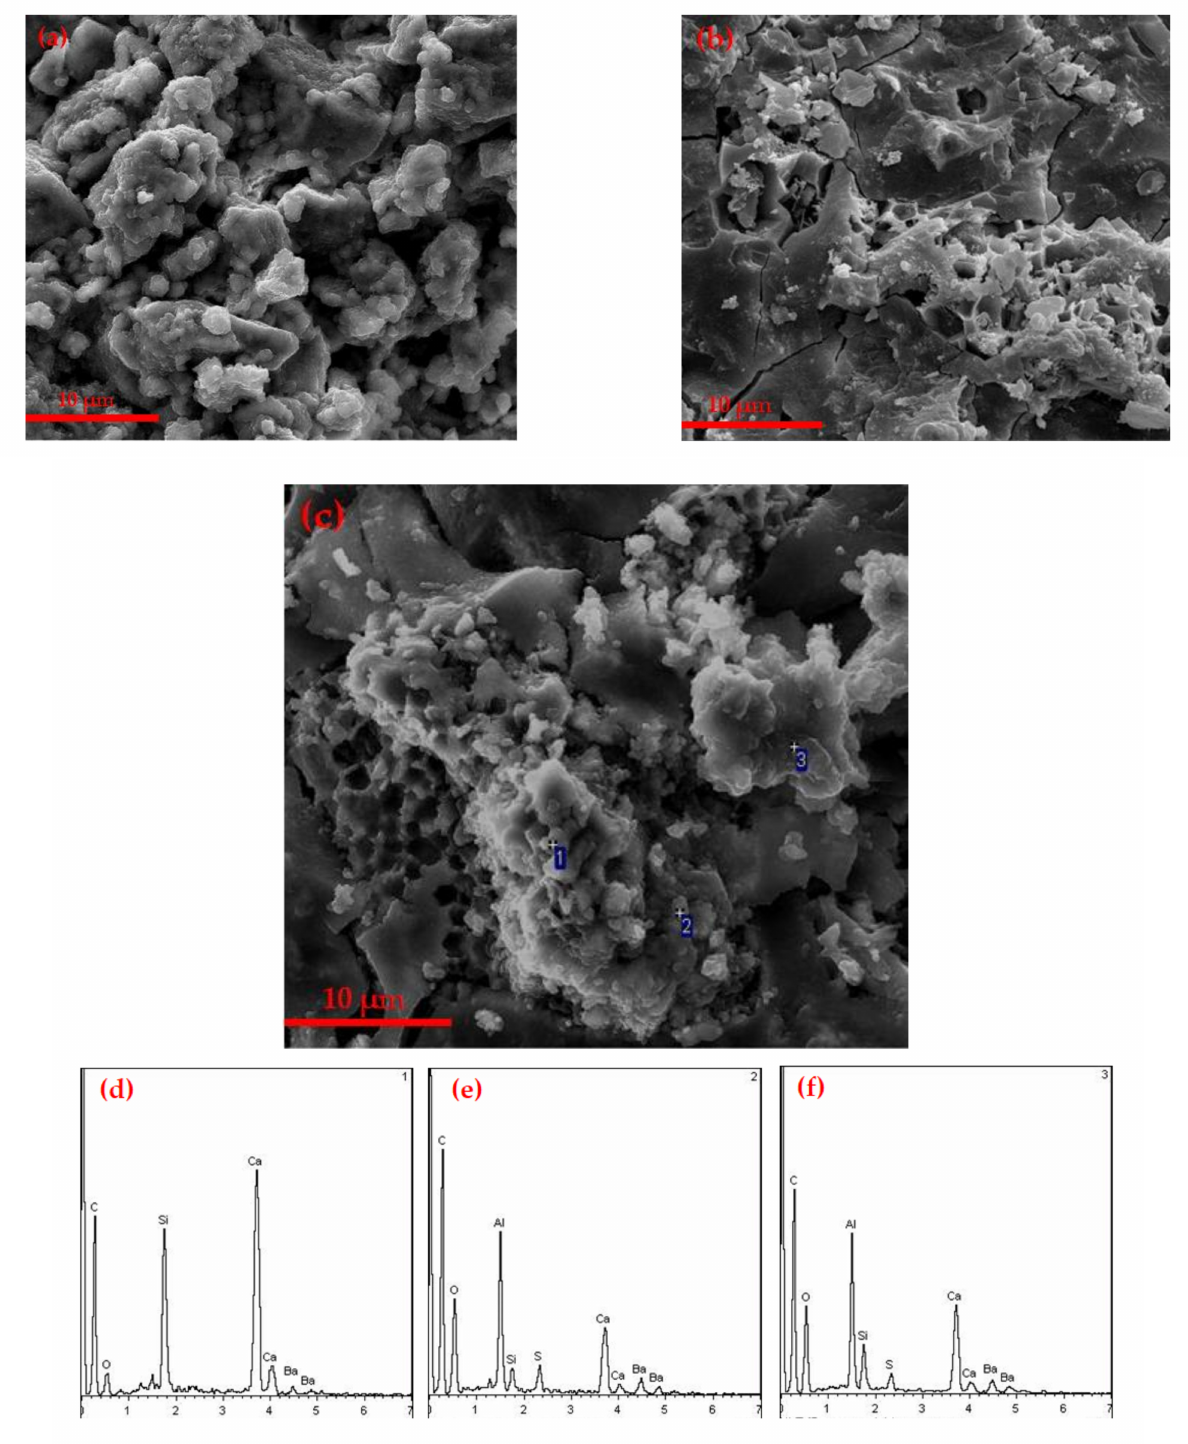
Figure 10. SEM of the ( a – c ) different C 4 AF contents of the clinker hydrated at 3 days, ( d ) 1-EDS, ( e ) 2-EDS, ( f )